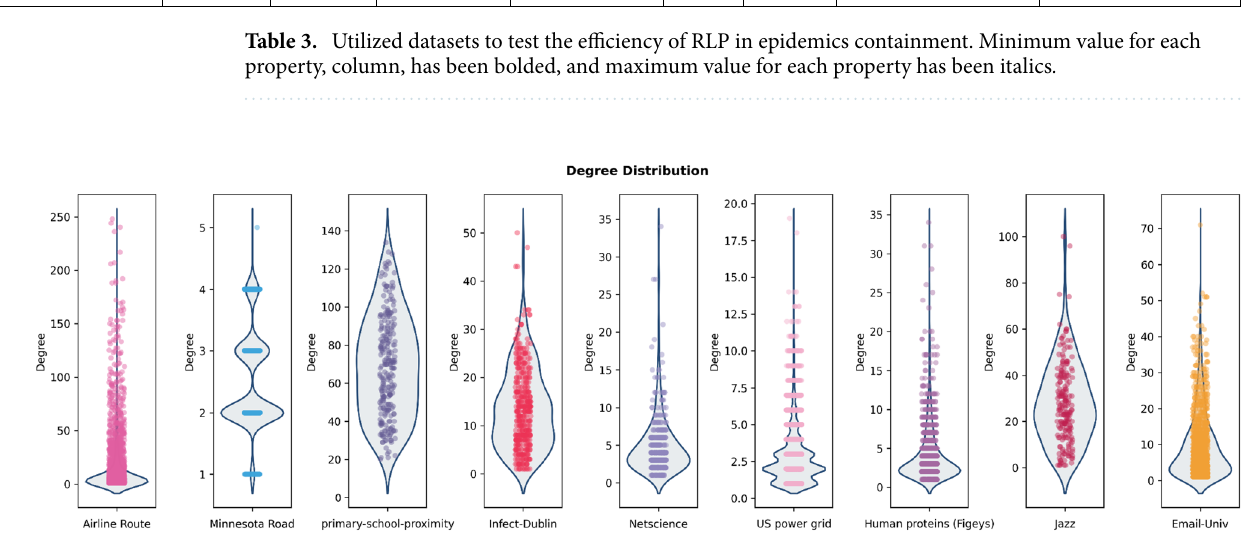
Figure 2. Violin plot of the degree distribution of probed datasets make the visual comparison